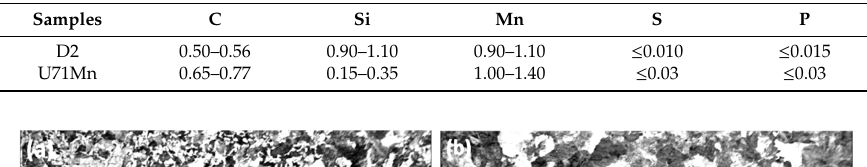
Table 1. Chemical components of the wheel-rail samples (%).